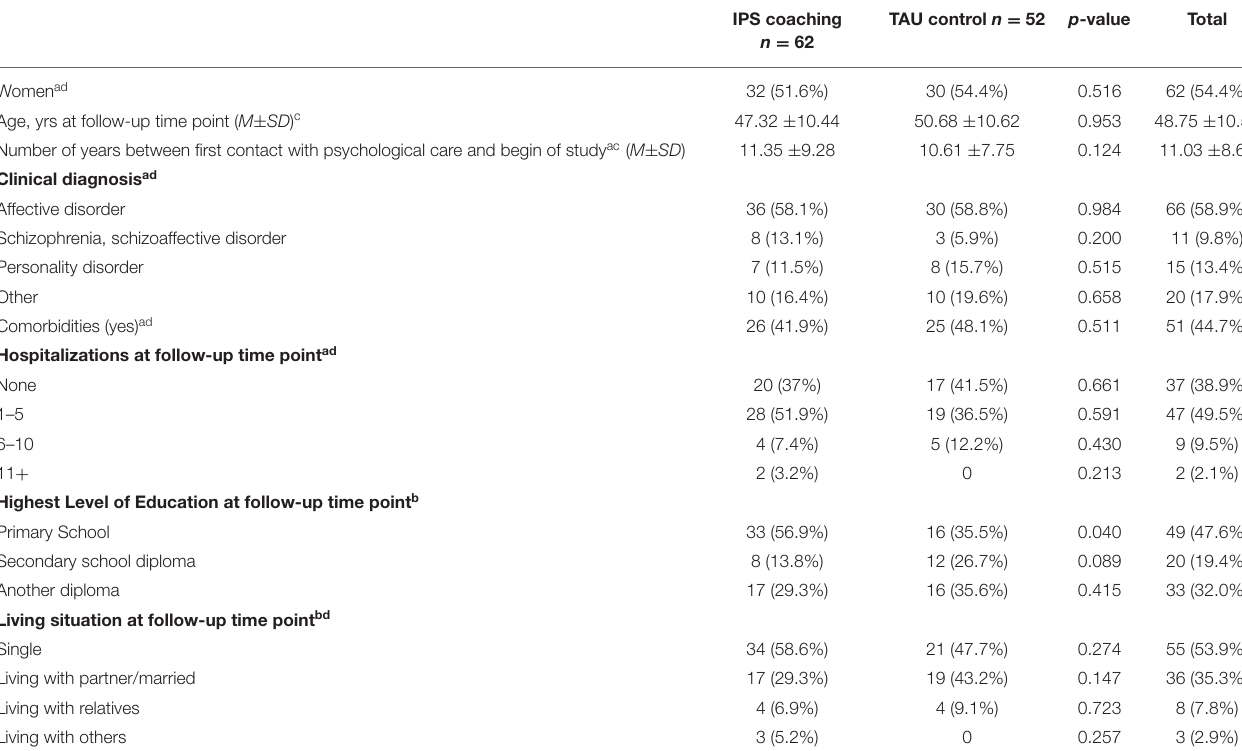
TABLE 1 | Participant characteristics Follow-up study ( n = 114).